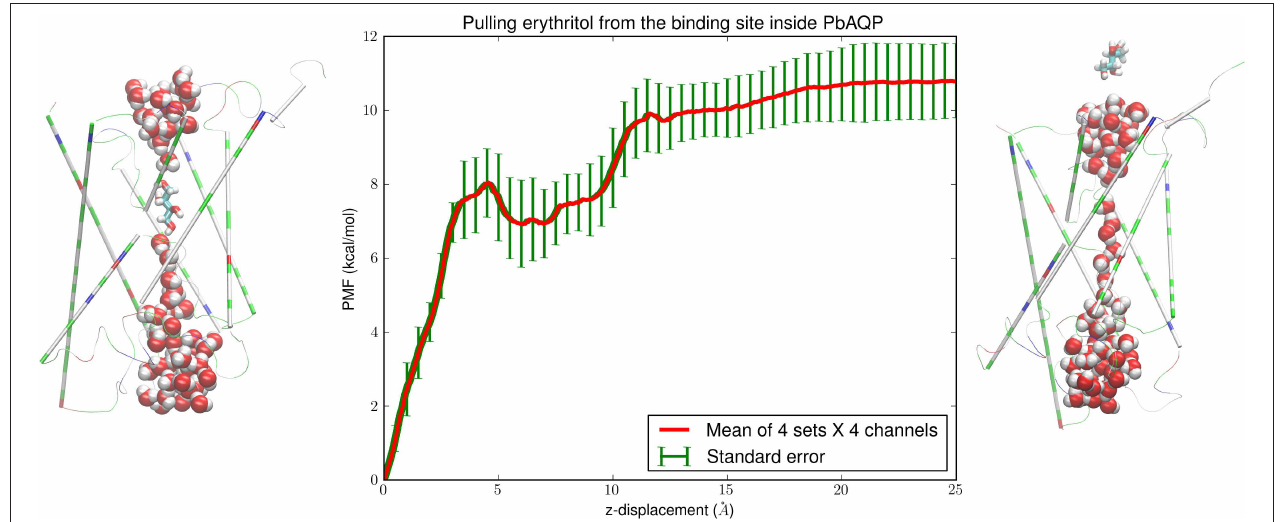
FIGURE 4 | Erythritol-PbAQP interactions. (Left) erythritol bound inside PbAQP near the NLA-NPS motifs interrupts the single file of waters through the channel. (Right) erythritol is held outside the channel and waters line up in single file throughout the channel. The representation and color schemes are identical to Figure 1 except that erythritol is shown in licorices. (Central) the PMF along the dissociation path of erythritol from the binding site to the intracellular side. The mean values and the standard errors are over 16 sets of data (four sets of forward and reverse paths in each of the four channels of the PbAQP tetramer).